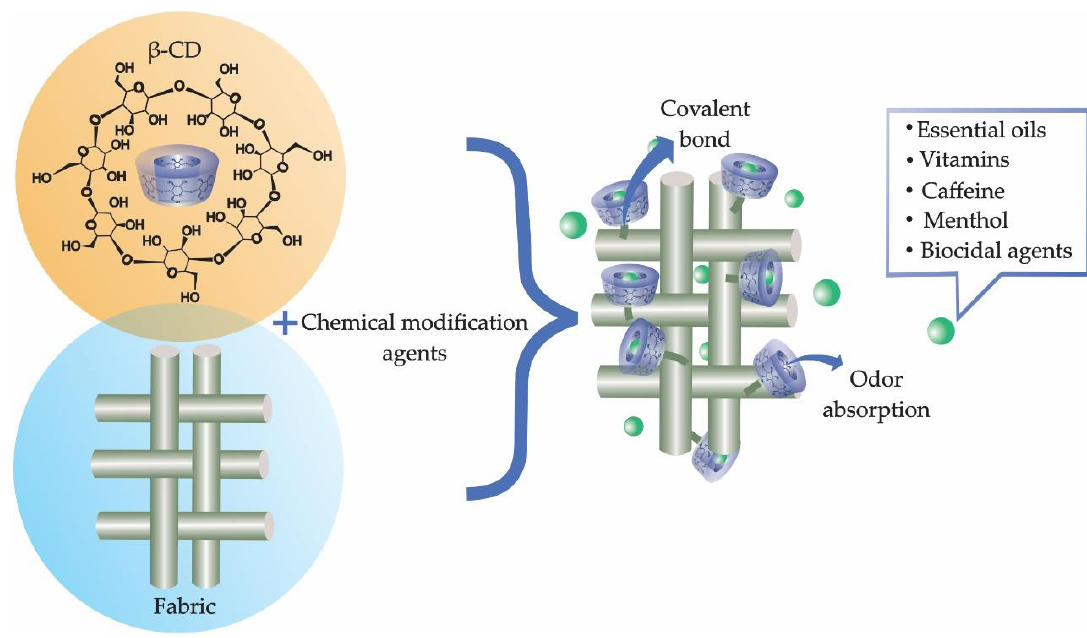
Figure 4. Use of cyclodextrins in textile finishing.